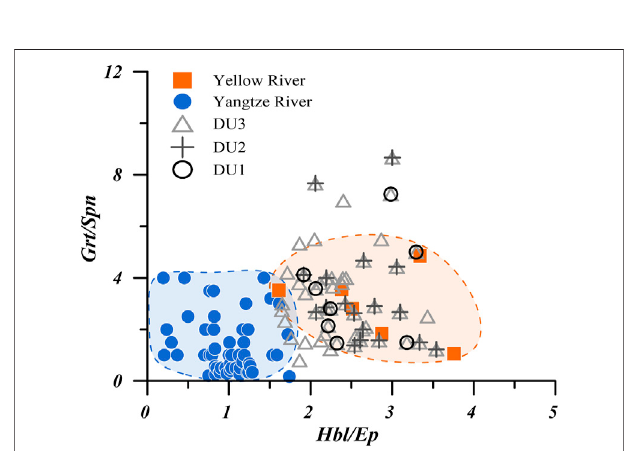
FIGURE 6 | GS – HE provenance discrimination diagram of core H10. Data regarding the Yellow River and Yangtze River are from Jin et al. (2019) and Wang et al. (2007), respectively. GS, garnet/sphene (Grt/Spm); HE, hornblende/epidote (Hbl/Ep).